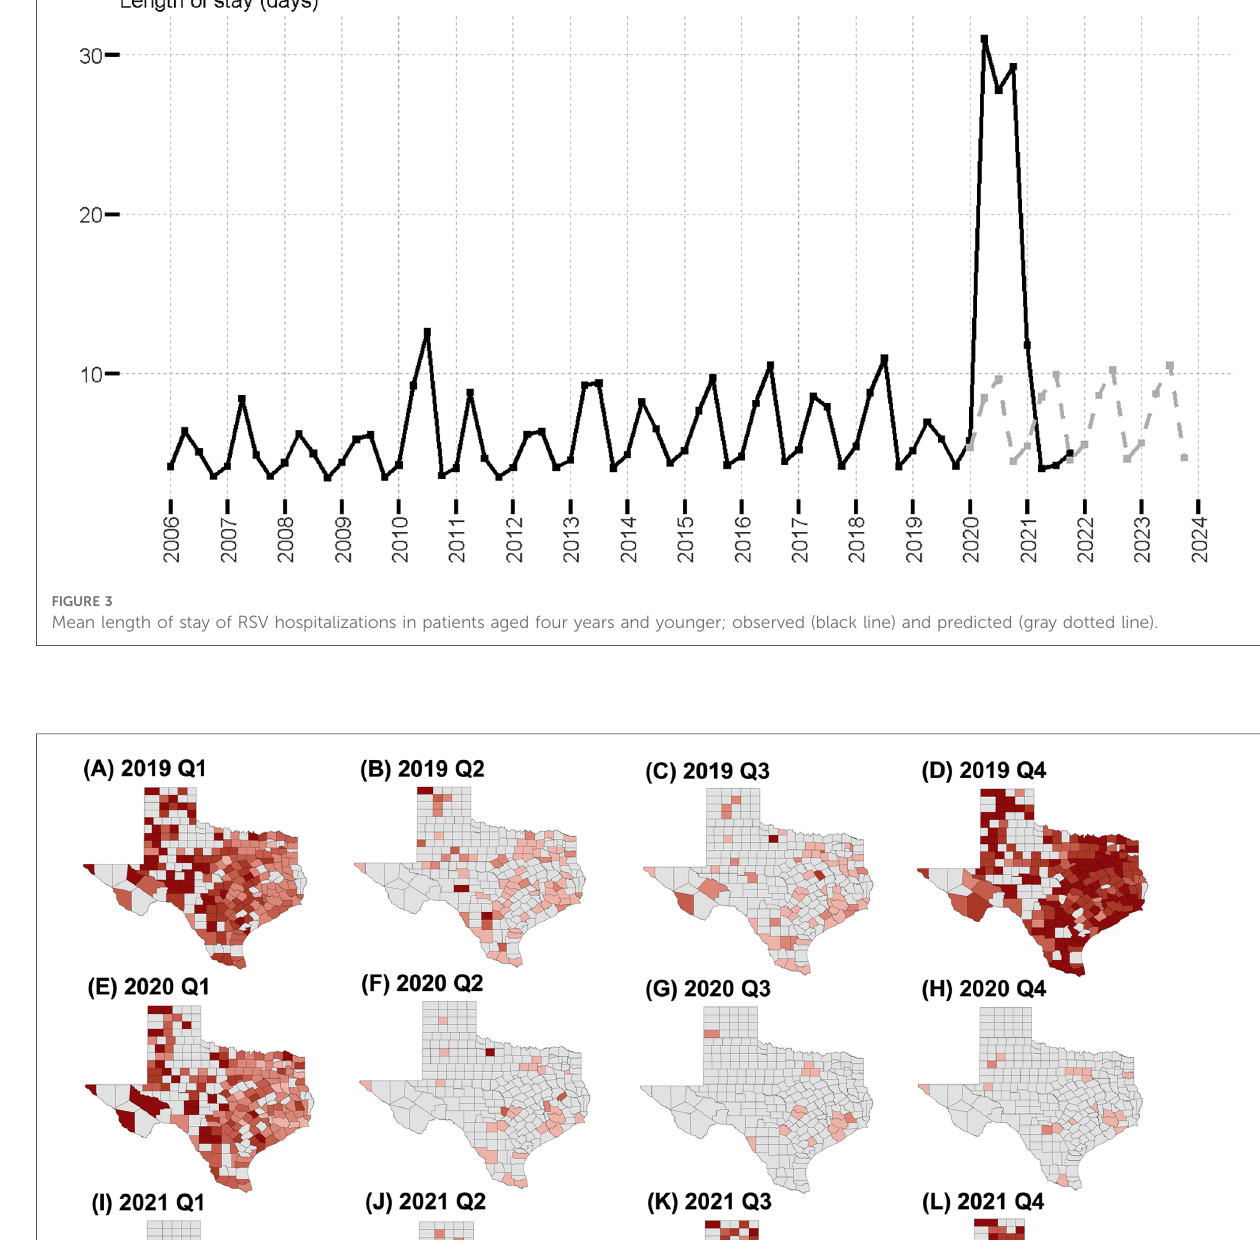
accounting for urban El Paso County) no cases were observed during and after COVID-19, but cases were reported prior to 2020 Q2.